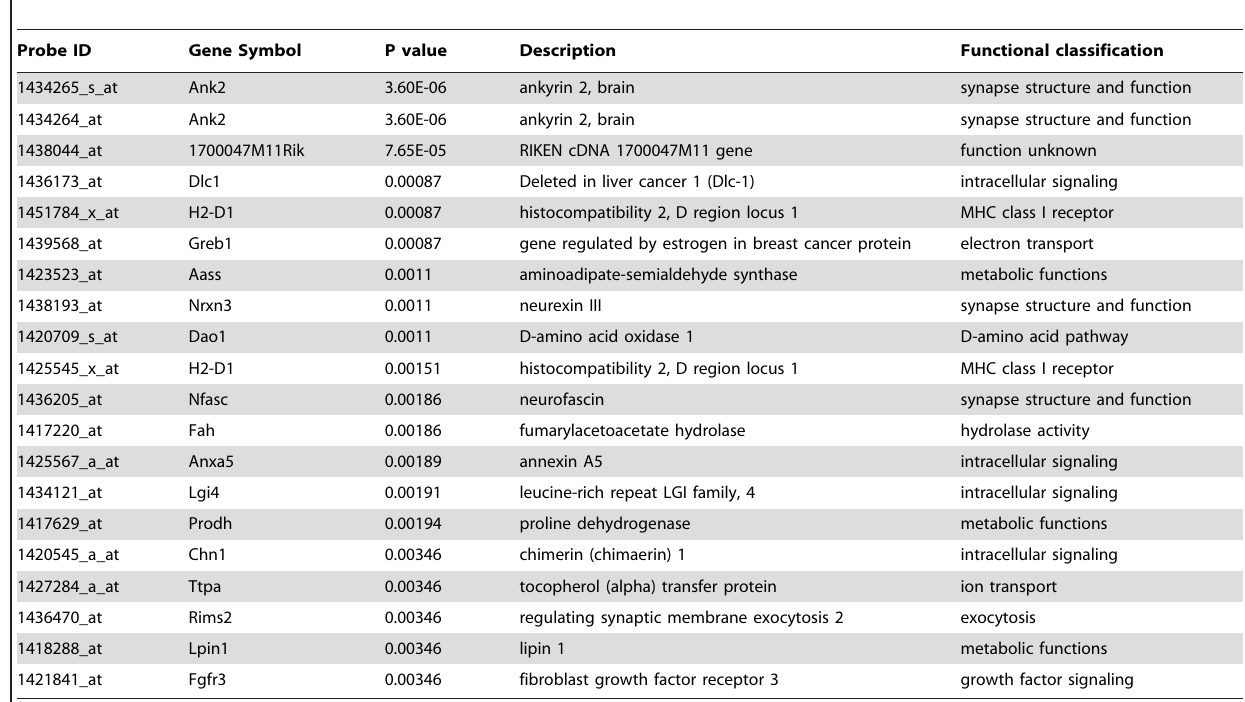
Table 4. Top 20 probe-sets present at P30 and absent at P6 (ranked by P values).